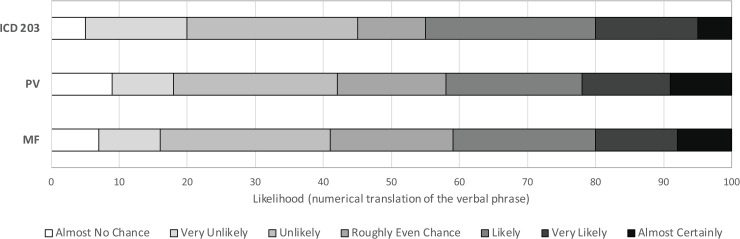
Evidenced-based lexicons obtained using two methods, Peak value (PV) and Membership function (MF), of calculating maximally representative ranges for each of seven commonly used verbal probability phrases, which are also contained in the US Intelligence Community Directive ICD 203 guidelines.For the PV and MF derived lexicons, the cut-off between phrases is where the average participant is equally likely to have assigned that value to each of two adjacent phrases.